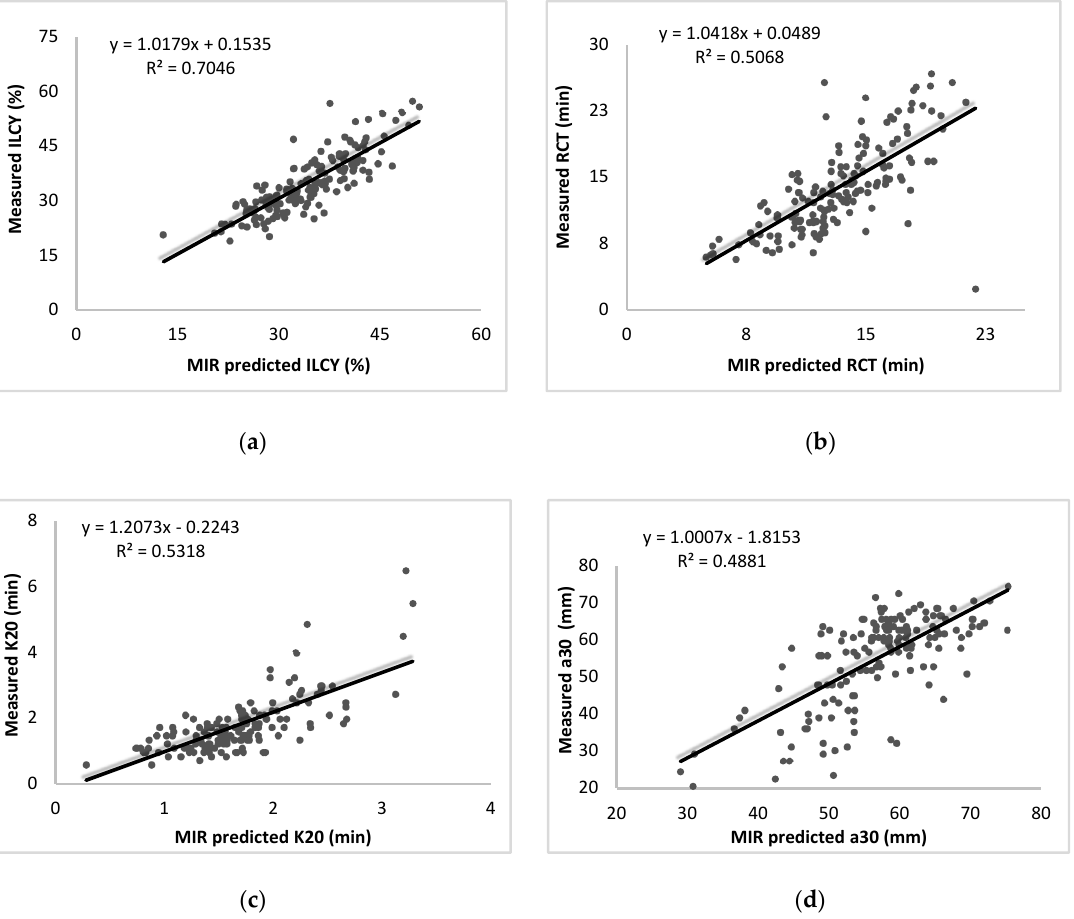
Figure 1. Partial least squares (PLS)-predicted individual laboratory cheese yield (ILCY) ( a ), rennet coagulation time (RCT) ( b ), curd-firming time (k20) ( c ), and curd firmness at 30 min (a30) ( d ), using the reduced MIR spectrum without locally weighted scatterplot smoothing (LOWESS) correction plotted against observed values.